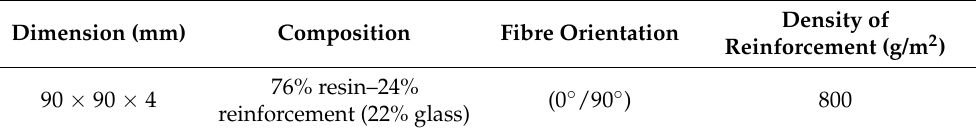
Table 2. Characteristics of the GFRP coupons.